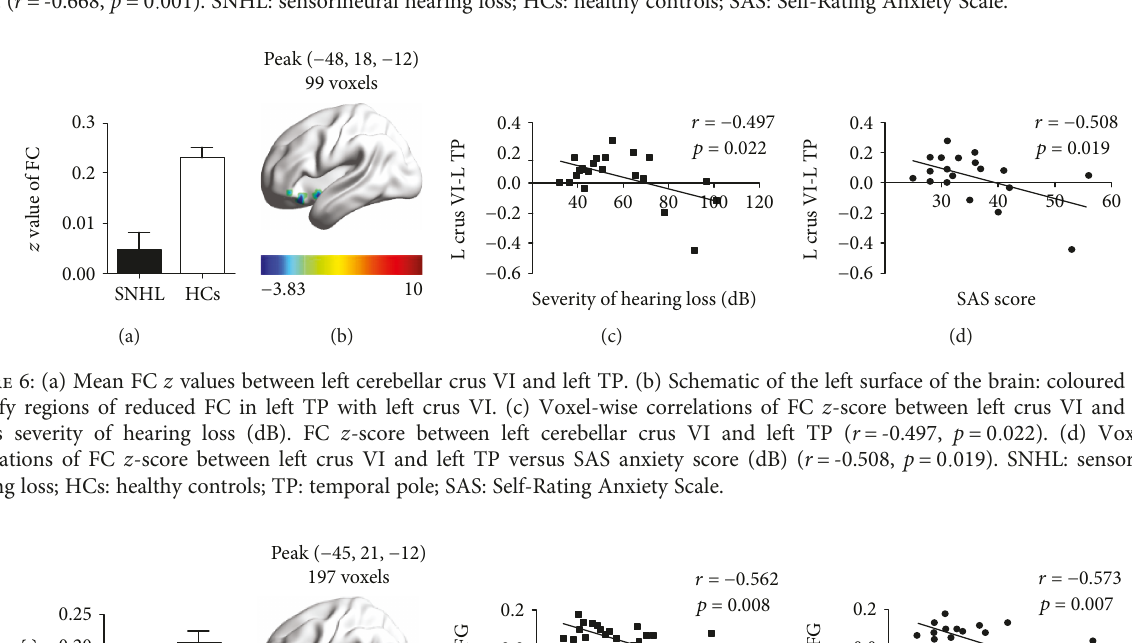
Figure 5: (a) Mean FC z values between left cerebellar crus VI and left insula. (b) Schematic of the left surface of the brain: coloured areas identify regions of reduced FC in the left insula from left crus VI. (c) FC z -scores between left crus VI and left insula versus the SAS anxiety score in the SNHL group. SAS scores were negatively correlated with z -score values of FC between left cerebellar crus VI and left insula ( r =-0.668, p = 0 001 ). SNHL: sensorineural hearing loss; HCs: healthy controls; SAS: Self-Rating Anxiety Scale.